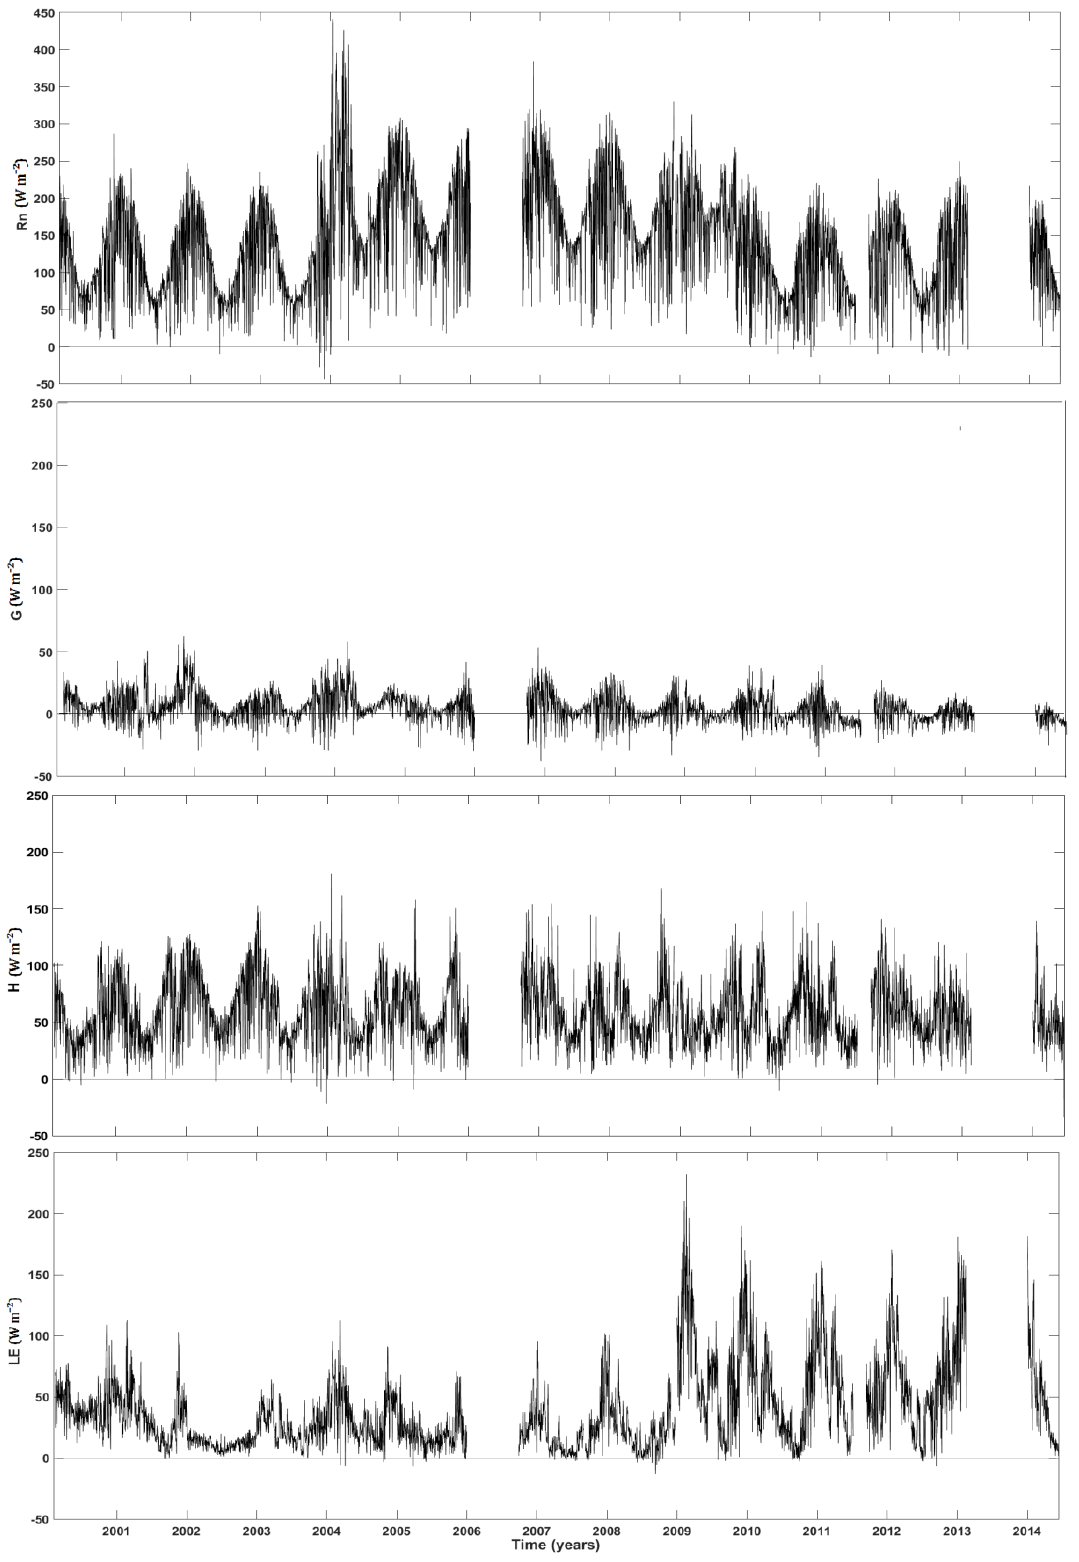
Figure 6. Time series of daily mean surface energy balance component fluxes from 2000 to 2014 at Skukuza flux tower site (SA).